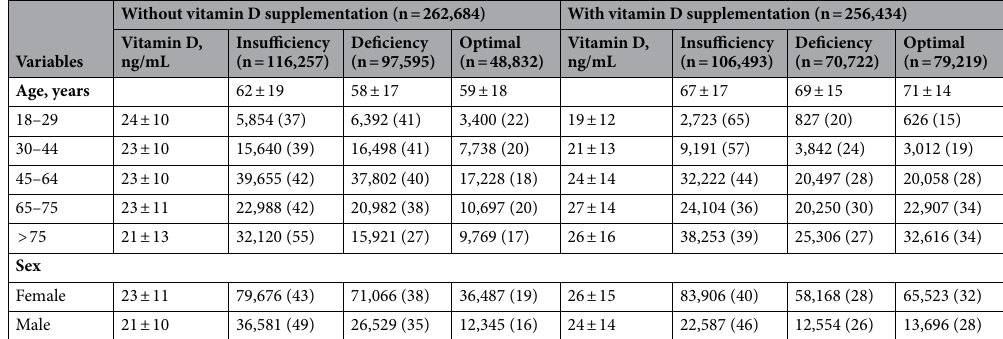
Table 2. Population categorization according to vitamin D level group and presence of supplementation. Categorical variables are presented as absolute frequencies (percentages) and continuous variables as the mean ± standard